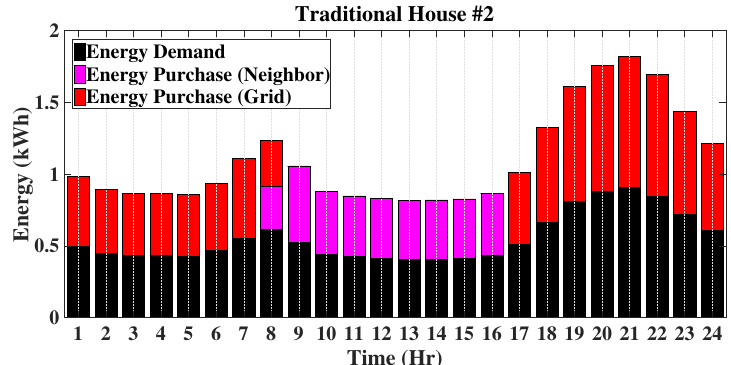
Figure 11. Energy profiles of Traditional House #2 on a typical summer day.